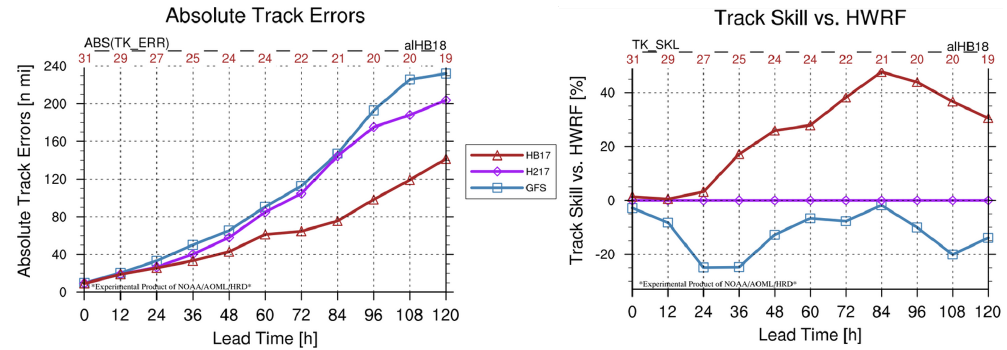
Figure 1. Track performance for Hurricane Harvey. HB17 is shown in red lines with triangle markers, H217 is purple with diamond markers, and GFS is blue with square markers. The left panel shows the absolute track errors and the right panel shows the track skill using H217 as a